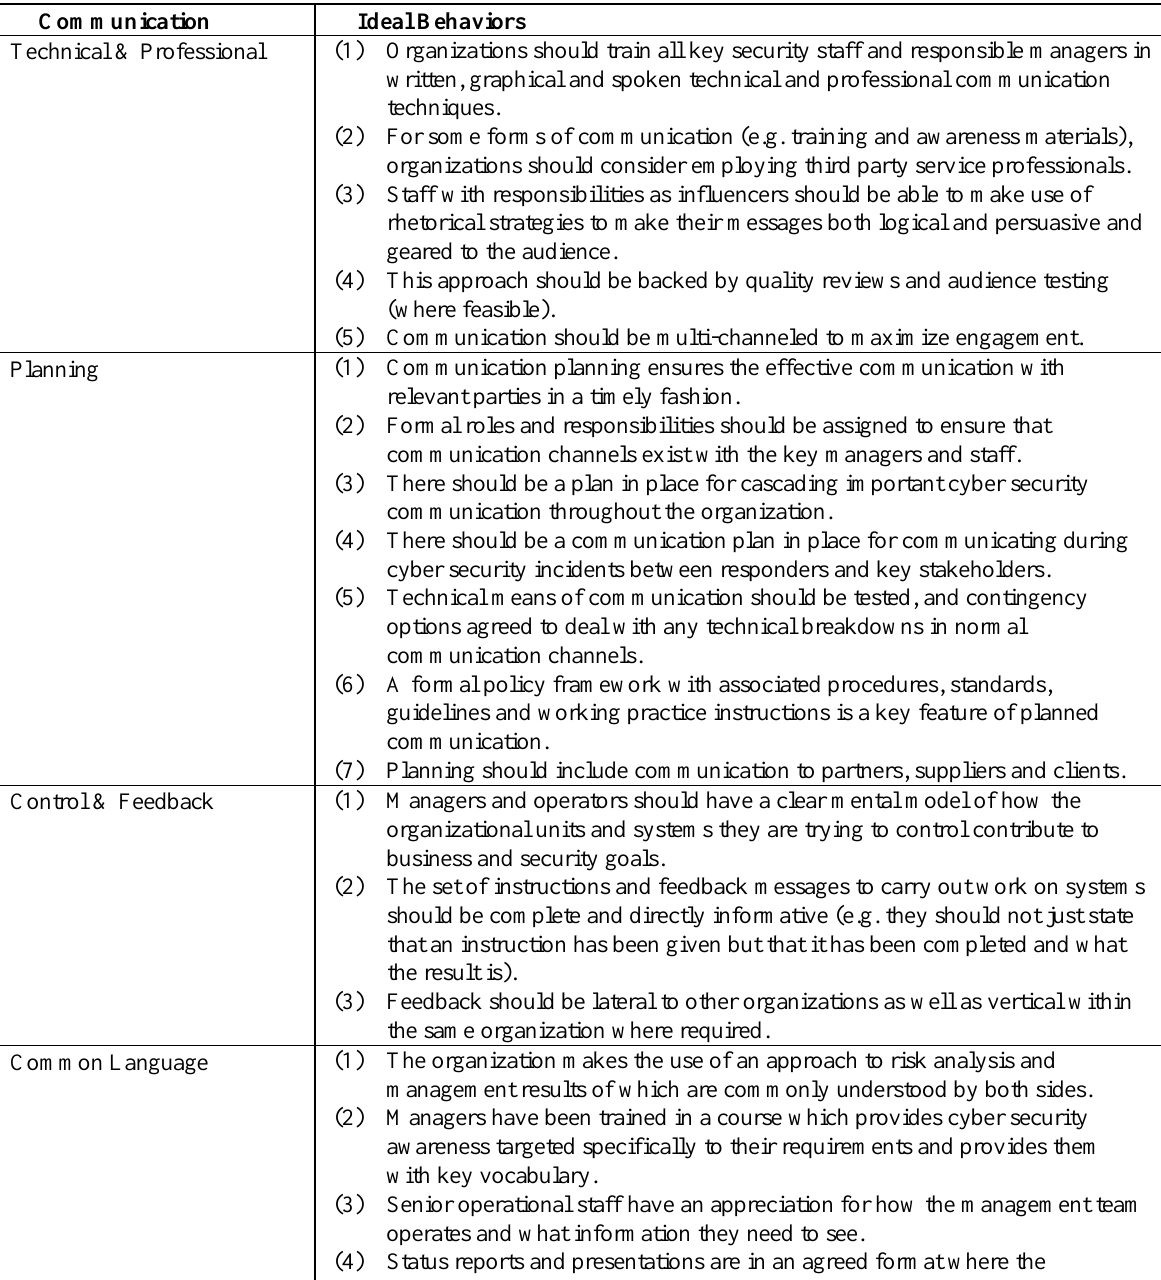
Table 2. Communication: Ideal